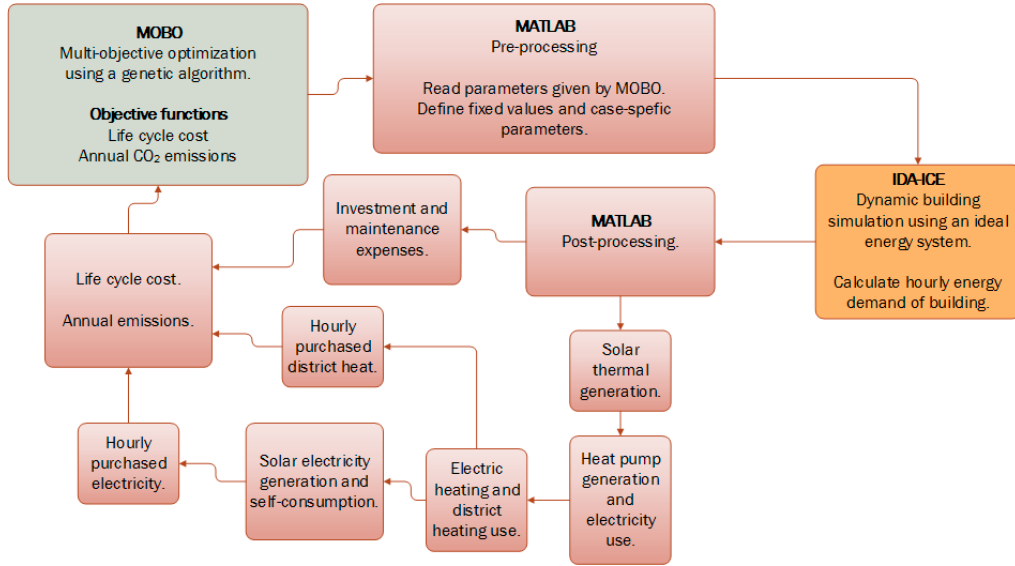
Figure 1. The optimization process that combines the three tools.